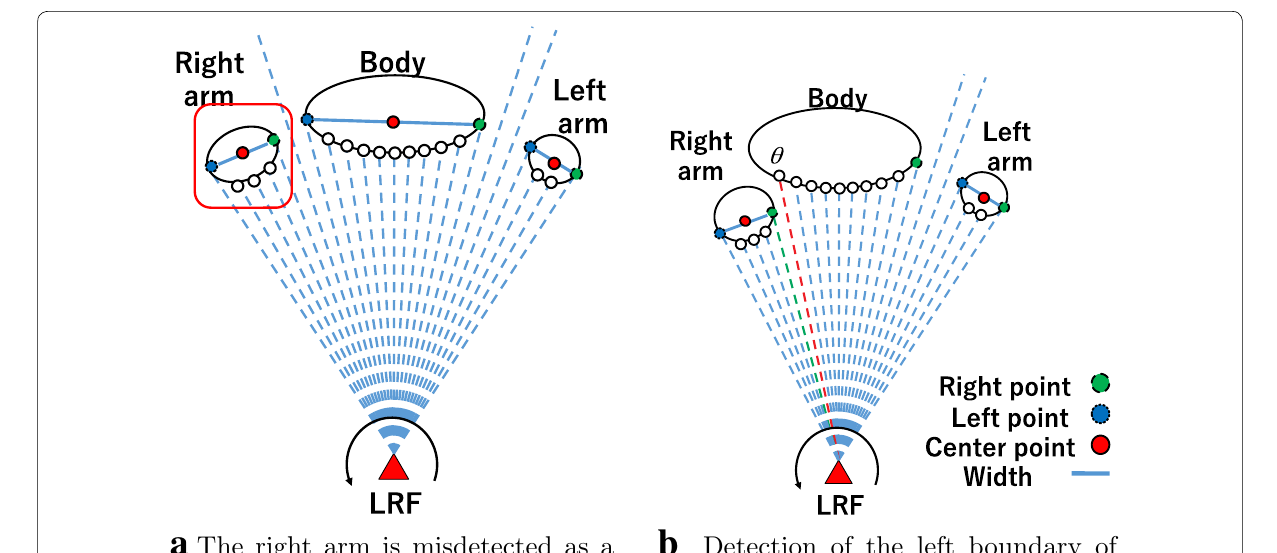
Fig. 6 Problems of person detection